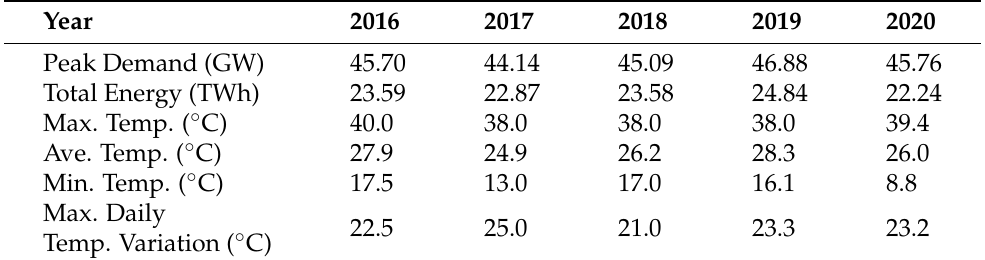
Table 1. Demand and temperature of month of April in the KSA from 2016–2020.